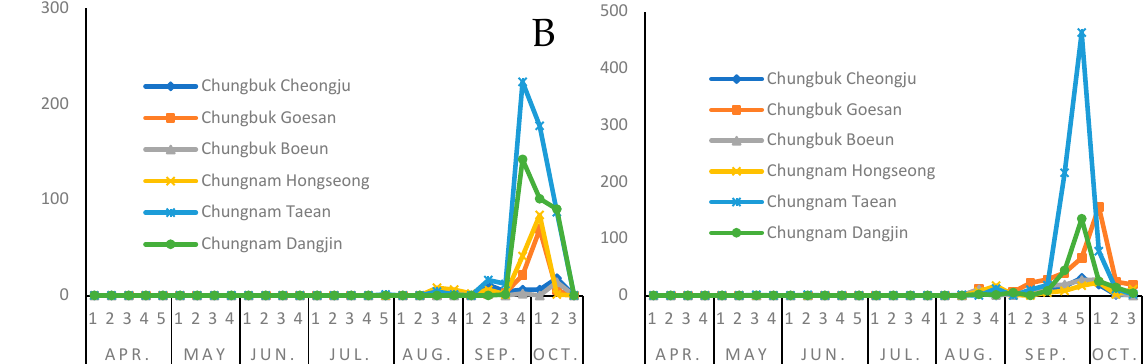
Figure 2. Seasonal occurrence trends of adult Spodoptera frugiperda from 2020 to 2021 ( A ): 2020; ( B ): 2021).